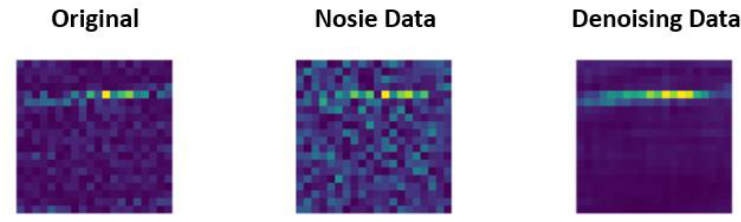
Figure 5. Original data, data with noise added, and data with noise